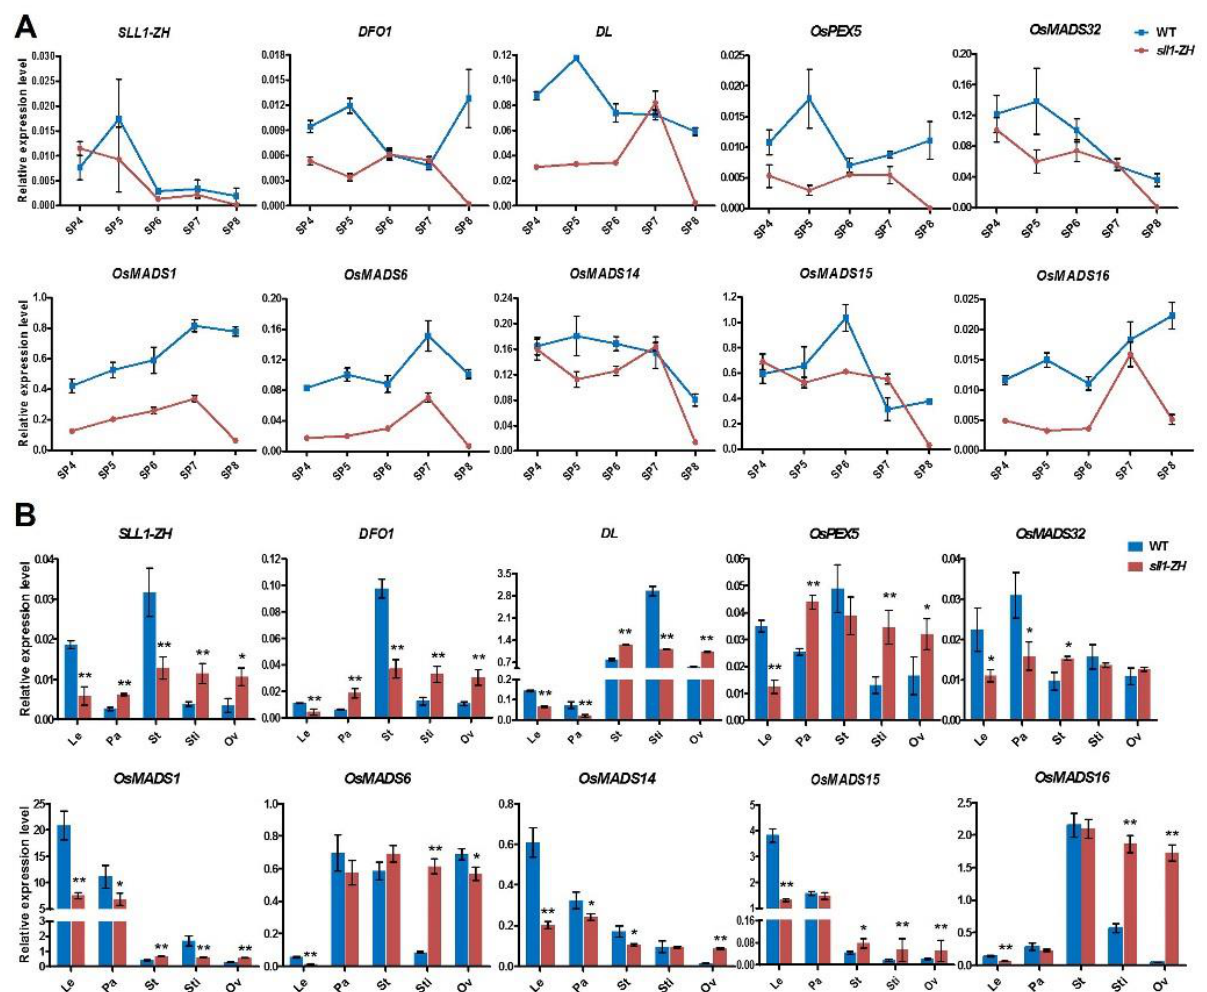
Figure 4. Transcription analysis of rice floral organ development factors in WT and the sll1-ZH mutant. ( A ) Relative ex- pression levels of floral organ identity genes in young inflorescences at different development stages in the WT and sll1-ZH mutant. ( B ) Relative expression levels of related genes in the different floral organs in mature spikelets in the WT and sll1-ZH mutant. Error bars show the SD ( n = 3 ). Student’s t -test was used for the statistical analysis (* and ** indicates significant difference at the p < 0.05 and p < 0.01 level, respectively). Le, lemma; Ov, ovary; Pa, palea; St, stamen; Sti, stigma.